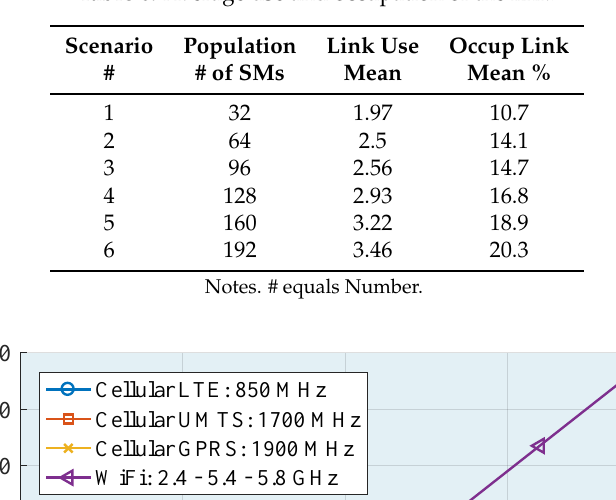
Table 6. Average use and occupation of the link.